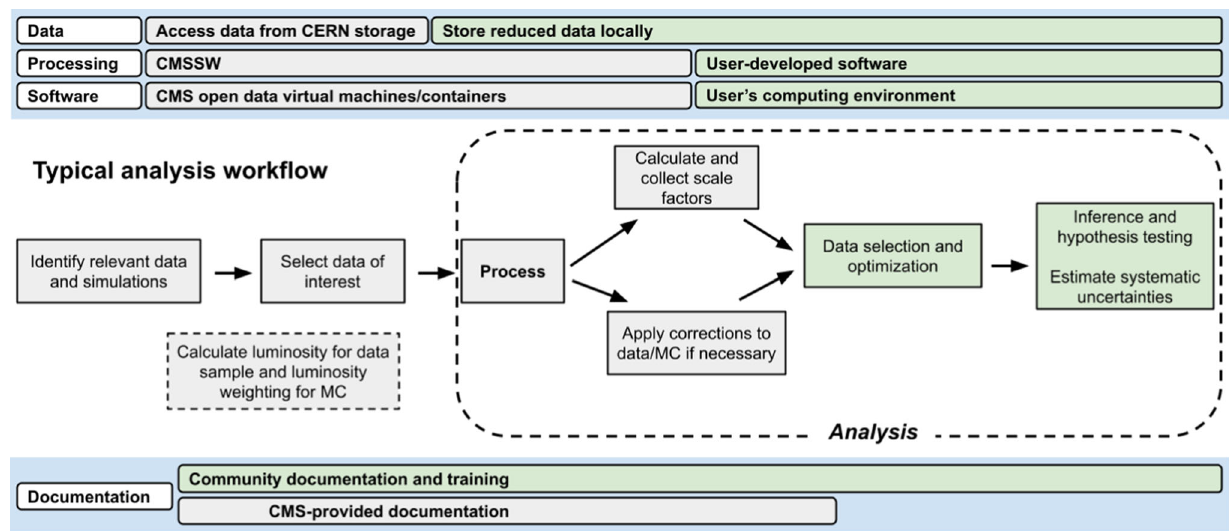
Fig. 17 AcoarseflowchartforatypicalanalysistakenfromRef.[768]. The upper part of the figure shows the hardware and software that an analyst might use for different stages of the analysis and the lower part of the figure shows where CMS’s documentation efforts span and end.